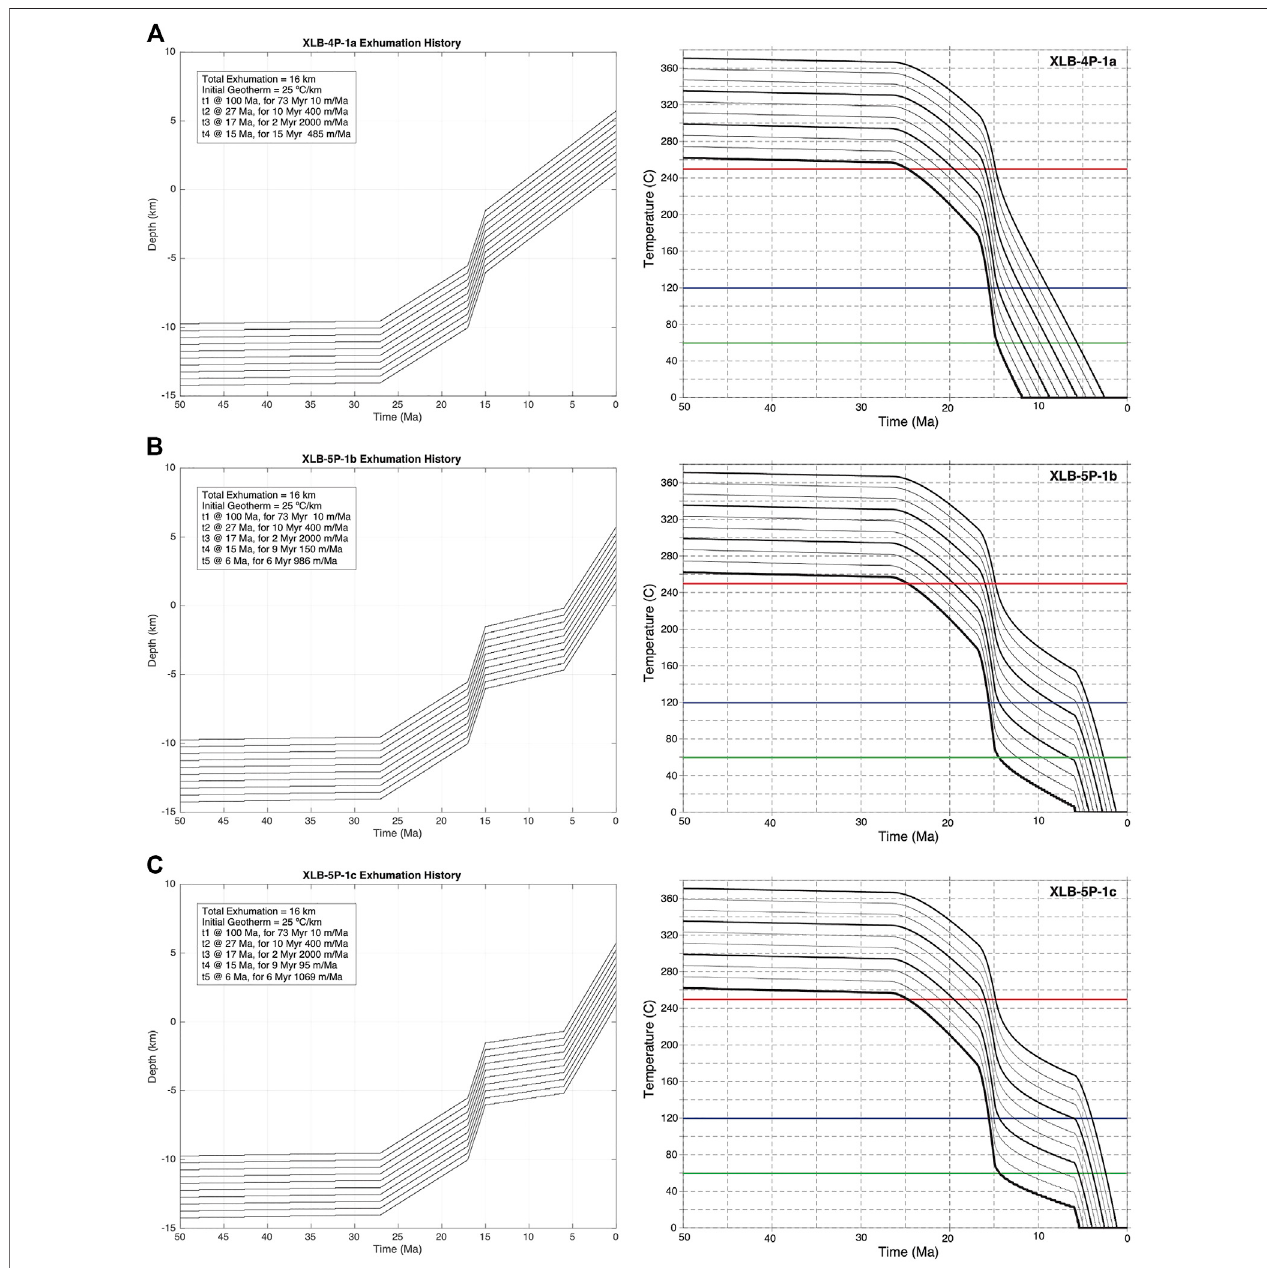
FIGURE 8 | Exhumation (left) and thermal (right) histories for three tectonic scenarios used to satisfy the observed Age - Elevation vertical pro fi les for the Xuelongbao transect Details in Table 1 . All scenarios involve approximately 16 km of exhumation over the past 100 Ma. The exhumation prior to 15 Ma is the same for eachmodel,butdifferssincethattime.Horizonsshownrepresenttherangeofinitialdepthsandtheir fi nalpositionsthatareconsistentwiththeelevationandextentofthe samples evaluated. Samples reach a surface T of 0 ° C when they reach of depth of 0 km, and remain at that T during the rest of their history (i.e., at depths above 0 km). (A) Simple 4-stage exhumation history with constant exhumation rate since 15 Ma. (B) 5 stage exhumation history with post-15 Ma separated into two exhumation periods (15 – 6 and 6 – 0 Ma). (C) 5 stage exhumation history as in panel (B) with slightly slower exhumation rates in the 15 – 6 Ma interval and slightly faster ratesinthe6 – 0 Mainterval.Implicationsofthesevariationsinexhumationhistoryareseeninthemodel fi tsof Figure9 (Note:Deepestburiedunitsinexhumationplotare top curves in Temperature plots).